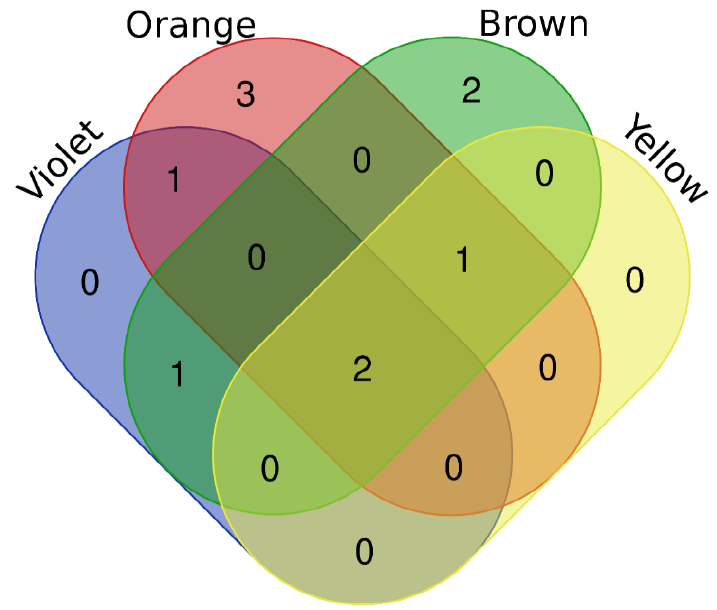
Figure 3. The number of Apis proteins identified in bee pollen samples of a given color. Table 2. Total protein concentration in aqueous solutions of bee pollen harvested in June and July 2018; SD—standard deviation; RSD—relative standard